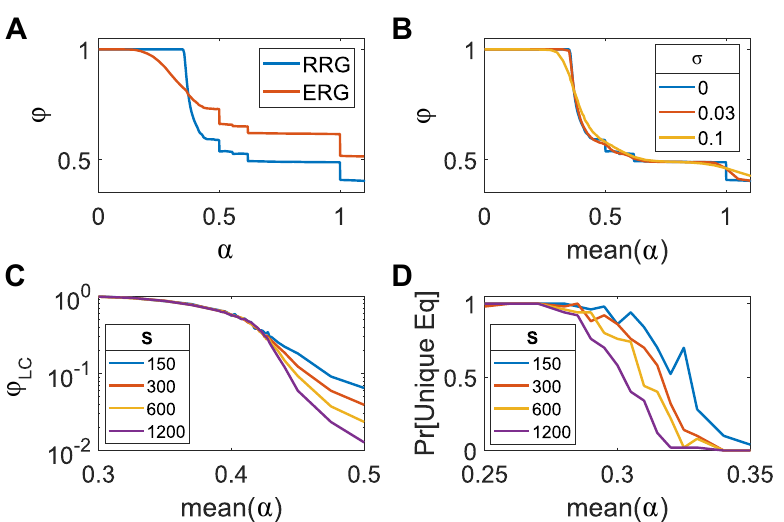
Fig 4. Transitions with heterogeneous interaction strengths and degrees. (A-B) Transitions due to changes in allowed trees are broadened when there is variability in interaction strengths, but remain sharp for variation in degree. The relative diversity ϕ as a function of interaction strength α , for S = 400, C = 3. (A) Erd ő s-Re´nyi graphs with interaction probability p = C / S , compared to a random C -regular graph. (B) Interaction strength is drawn from a normal distribution with mean α and standard-deviation σ = 0, 0.03, 0.1, keeping the interactions symmetric and a random regular graph. (C-D) The collective transitions with heterogeneity in interaction strength become sharper as S increases, just as they do without it (compare with Fig 3). Results are shown for C = 3, σ = 0.1 and several values of S . (C) Percolation transition: The fraction of species in the largest connected component as a function of α . (D) Unique to multiple equilibria transition: The probability of having a unique equilibrium as a function of α